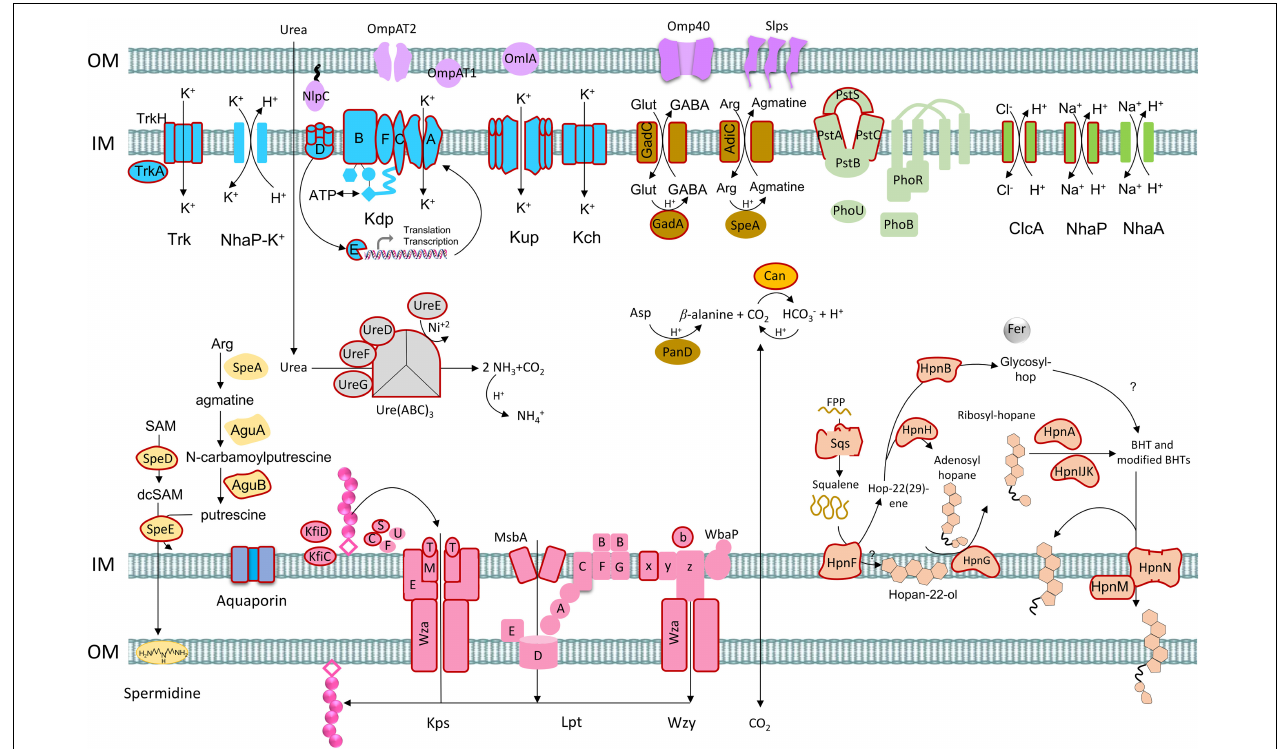
FIGURE 9 | Model of acid resistance genes and mechanisms in acidophiles from the Acidithiobacillaceae including first and second lines of defense. Gene gain events proposed by HGT are represented with outline colors in red according to phylogenetic/phylogenomic and prediction (Zhu et al., 2014)